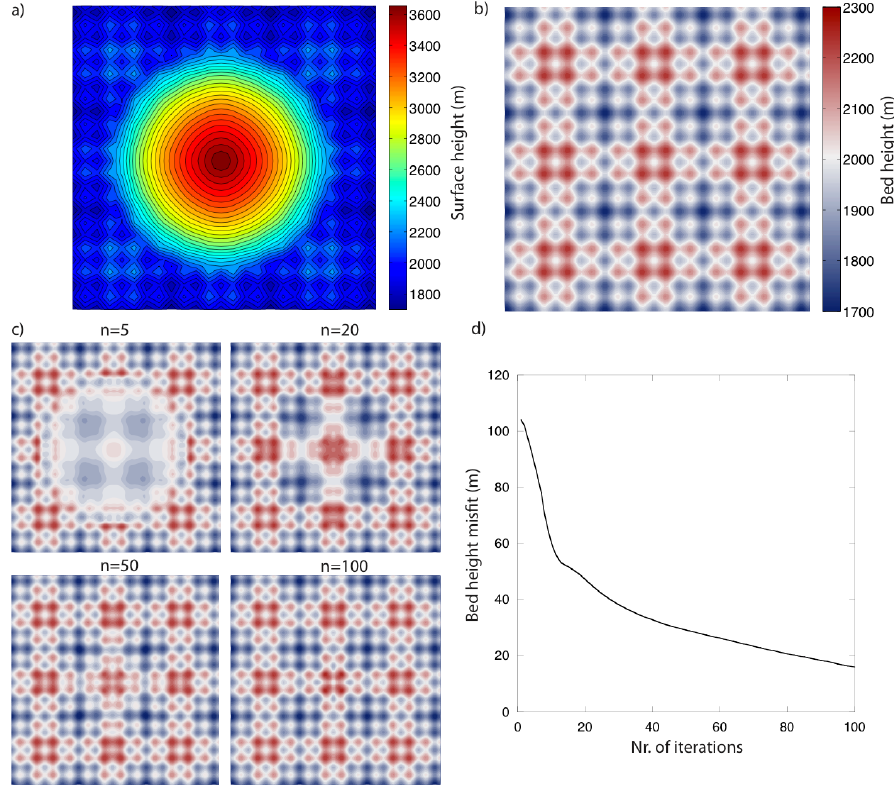
Fig. 5. Recovery of a bump field containing mixed bump sizes. The reference surface and bed are shown in (a) and (b) . The reference bed contains a superposition of bumps with an amplitude of 150m and a bump width varying by a factor 4. Panel (c) shows snapshots of the recovered bed height after n = 5, 20, 50 and 100 iterations. (d) shows the bed height misfit as a function of the number of